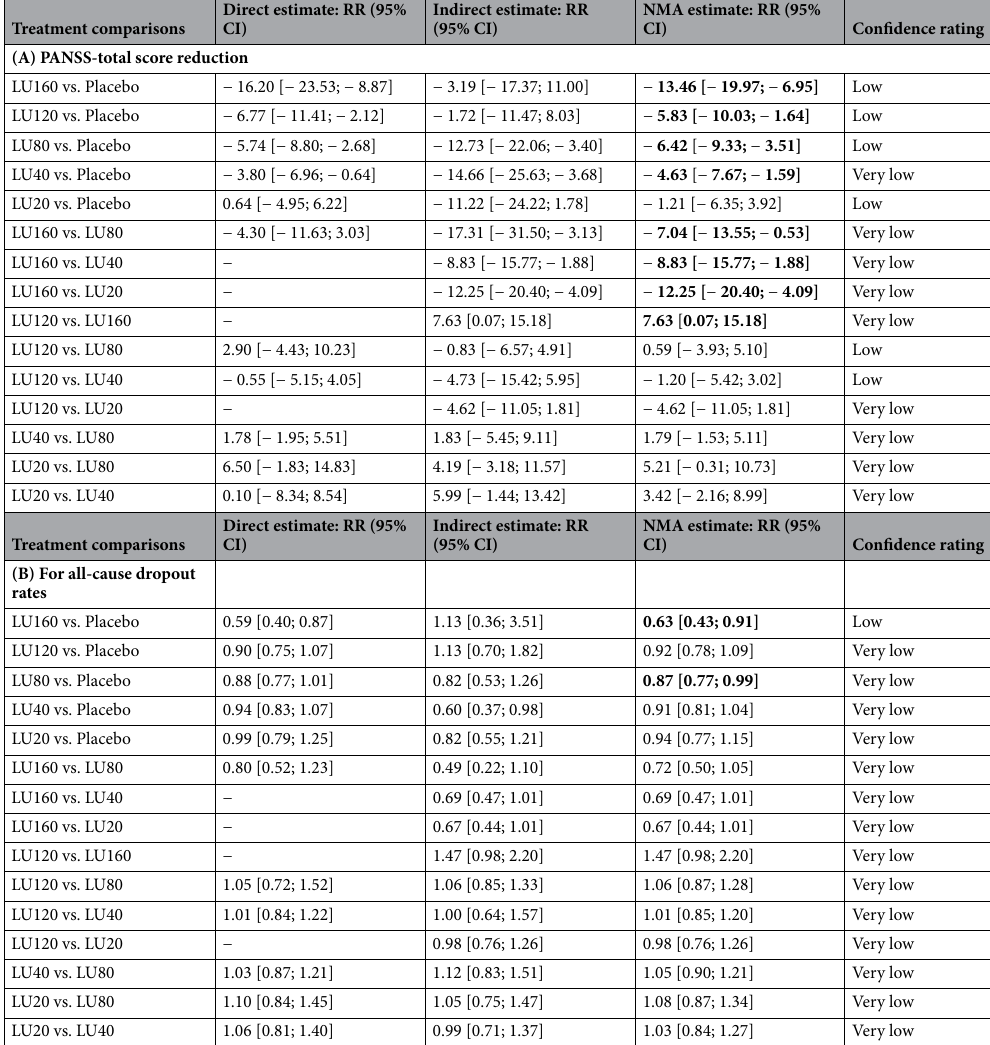
Table 3. Confidence rating and effect estimates of each comparison: lurasidone at different doses vs. placebo for acute schizophrenia. PLA: Placebo; LU20, LU40, LU80, LU120, LU160: Lurasidone 20, 40, 80, 120, 160 mg/ day,